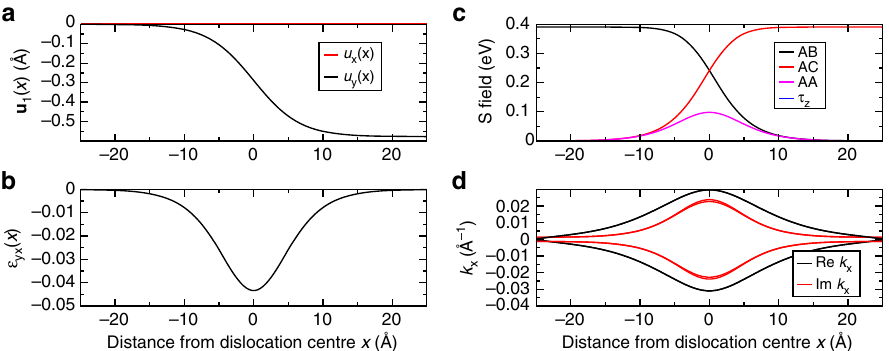
Fig. 6 Continuum description of a partial dislocation. We show here the case of a type three partial; types 1 and 2 show similar behaviour. a The displacement vector of the two layers u ( x ), with the fi rst layer is shifted by u ( x ) with respect to the second layer. b The strain state of the partial ε xy showing that the partial is under a modest strain taking its maximum value at the partial mid point. c The resulting effective fi eld S ( x ), see Eqs. (2) and (5), expressed as its decomposition onto a complete set of stacking matrices, AB, AC, AA and τ z stacking, see Eq. (9). Notice that the τ z fi eld is identically zero, and is in fact zero for all partial geometries. d The transport momenta. While this is purely imaginary within the terraces it is seen to acquire a real part within the partial